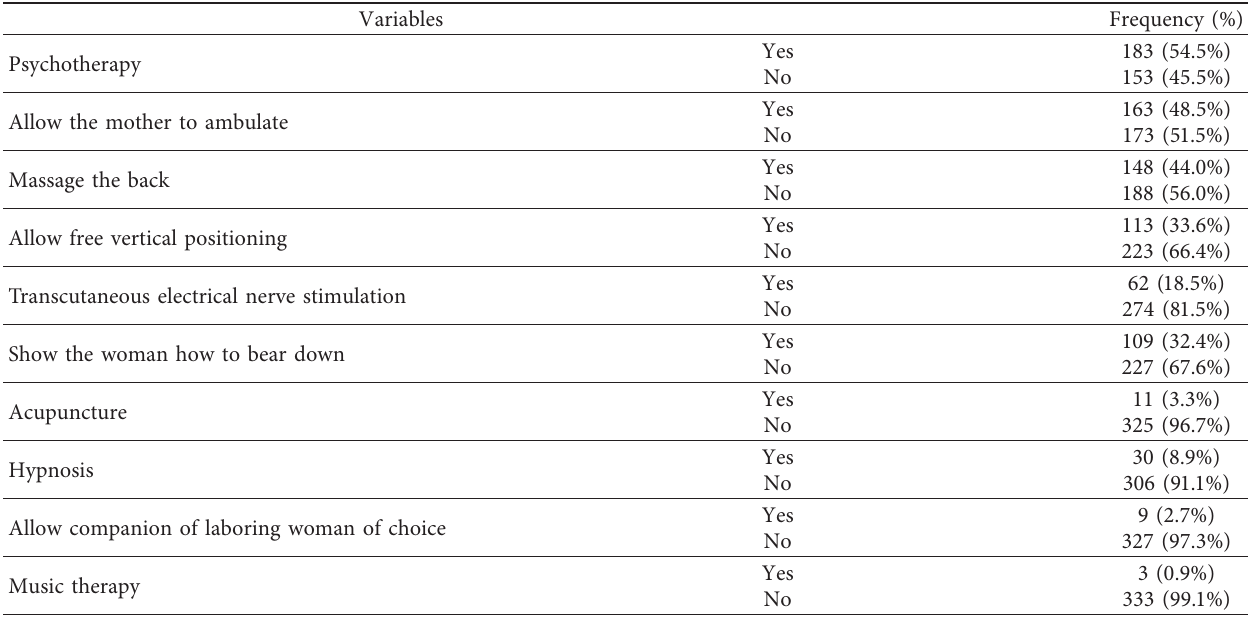
Table 2: Knowledge of SBAs on nonpharmacologic labor pain relief methods who are working at hospitals found in Gondar zones, northwest Ethiopia,